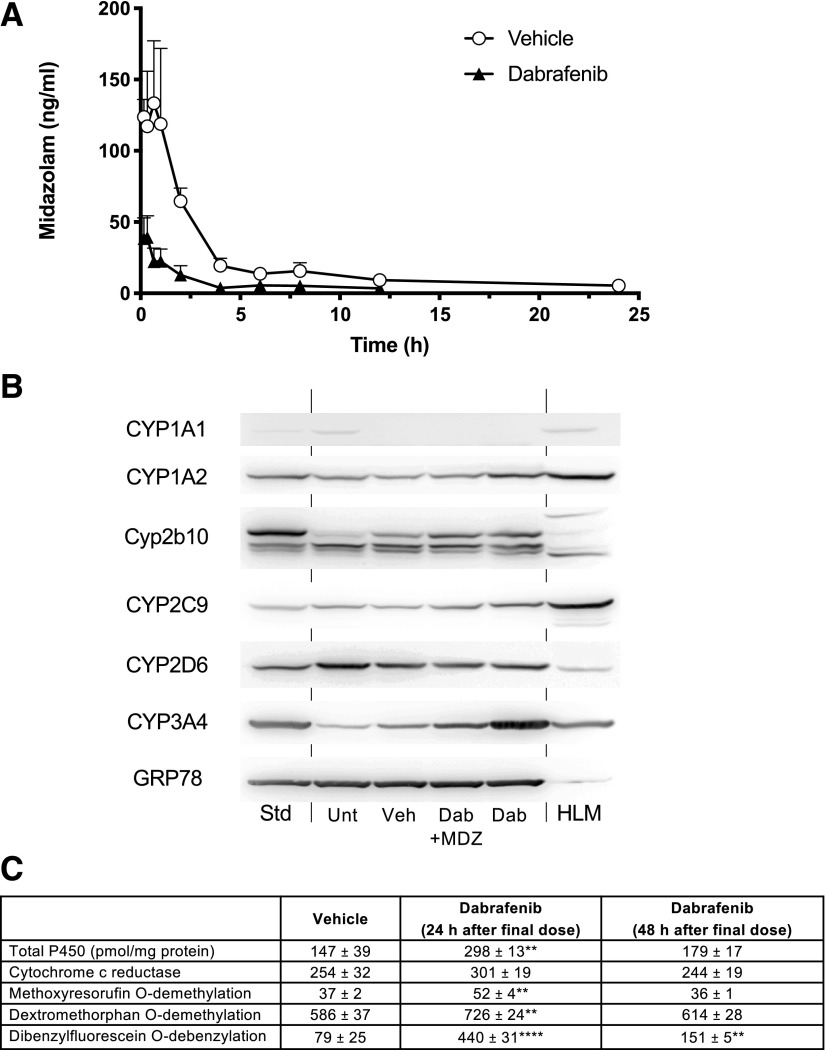
Effect of dabrafenib on midazolam pharmacokinetics in 8HUM mice. Adult female 8HUM mice (n = 3) were treated with vehicle or dabrafenib (10 mg/kg) PO daily for 2 days, and on day 3 were administered midazolam (3 mg/kg) PO and PK profiling carried out as described in Materials and Methods. (A) Pharmacokinetic profiling for midazolam in 8HUM mice receiving either vehicle (open circles) or dabrafenib (closed triangles). Data shown are mean ± S.D. (B) Immunoblotting of liver microsomes from 8HUM mice, untreated or treated as above, against mouse and human P450 isozymes. Dab, Dabrafenib; MDZ, midazolam; Unt, untreated; Veh, vehicle. One group of dabrafenib-treated mice (Dab) were sacrificed on day 3 without exposure to midazolam to determine the effects of dabrafenib on P450 expression at the start of the PK profiling. The other samples were collected after the completion of the PK study 24 hours later. Std, standard, recombinant human P450 protein or phenobarbital-treated liver microsomes (Cyp2b10); HLM, human liver microsomes. (C) Effects of dabrafenib treatment on hepatic cytochrome P450-related activities in liver microsomes from 8HUM mice 24 and 48 hours after drug treatment. Data shown are mean ± S.D. Unpaired t test (two tailed P values) statistically significant compared with vehicle **P ≤ 0.01; ****P ≤ 0.0001 for vehicle vs. dabrafenib at 24 or 48 hours, t test.